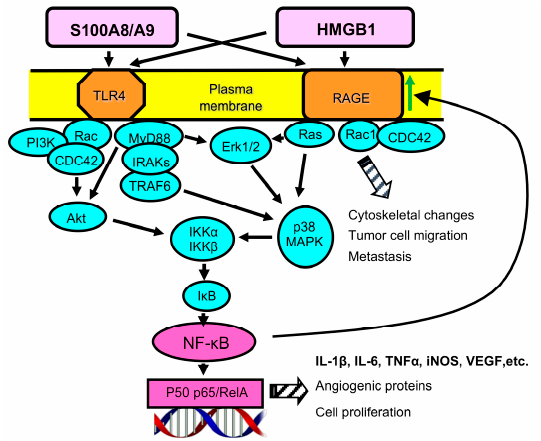
Figure 2. HMGB1 and S100A8/A9 are the dominant ligands for the plasma membrane receptors TLR4 and RAGE. When HMGB1 and S100A8/A9 bind to either TLR4 or RAGE, a complex intracellular signaling cascade is initiated, culminating in the translocation of NF-kB to the nucleus, where it initiates the synthesis of pro-inflammatory mediators and pro-angiogenic proteins and drives cell proliferation. NF-kB activation initiates a feed-forward loop, increasing RAGE expression (indicated by a green arrow). S100A8/A9 and HMGB1 may also individually induce crosstalk between TLR4 and RAGE, thereby simultaneously activating both signal transduction pathways.